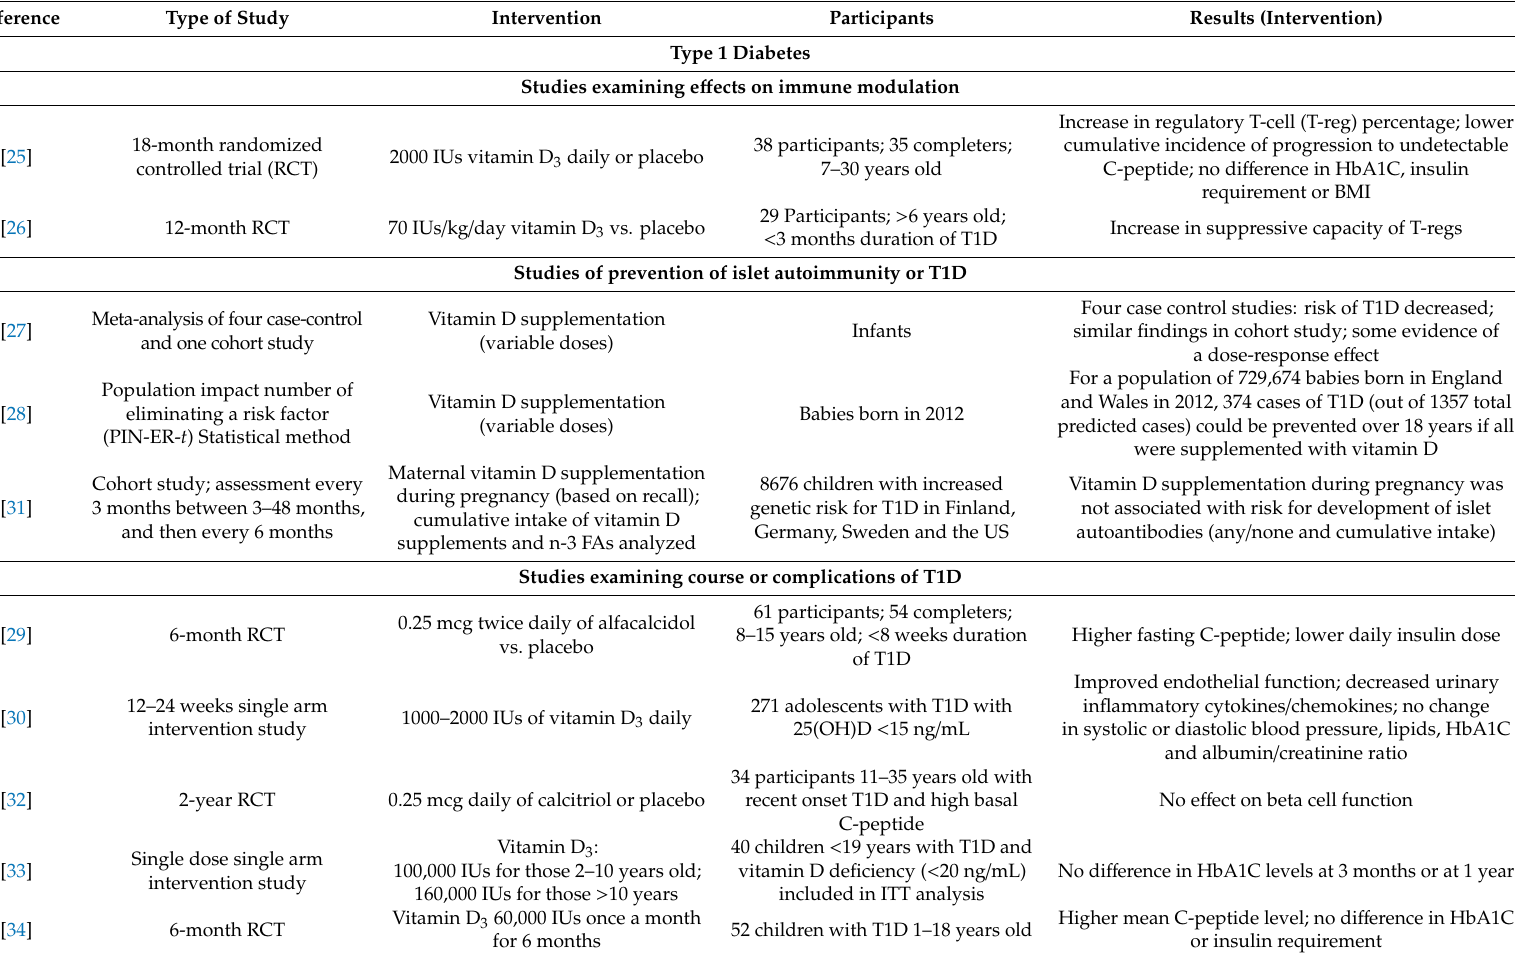
Table 1. Summary of studies of vitamin D administration in type 1 and type 2